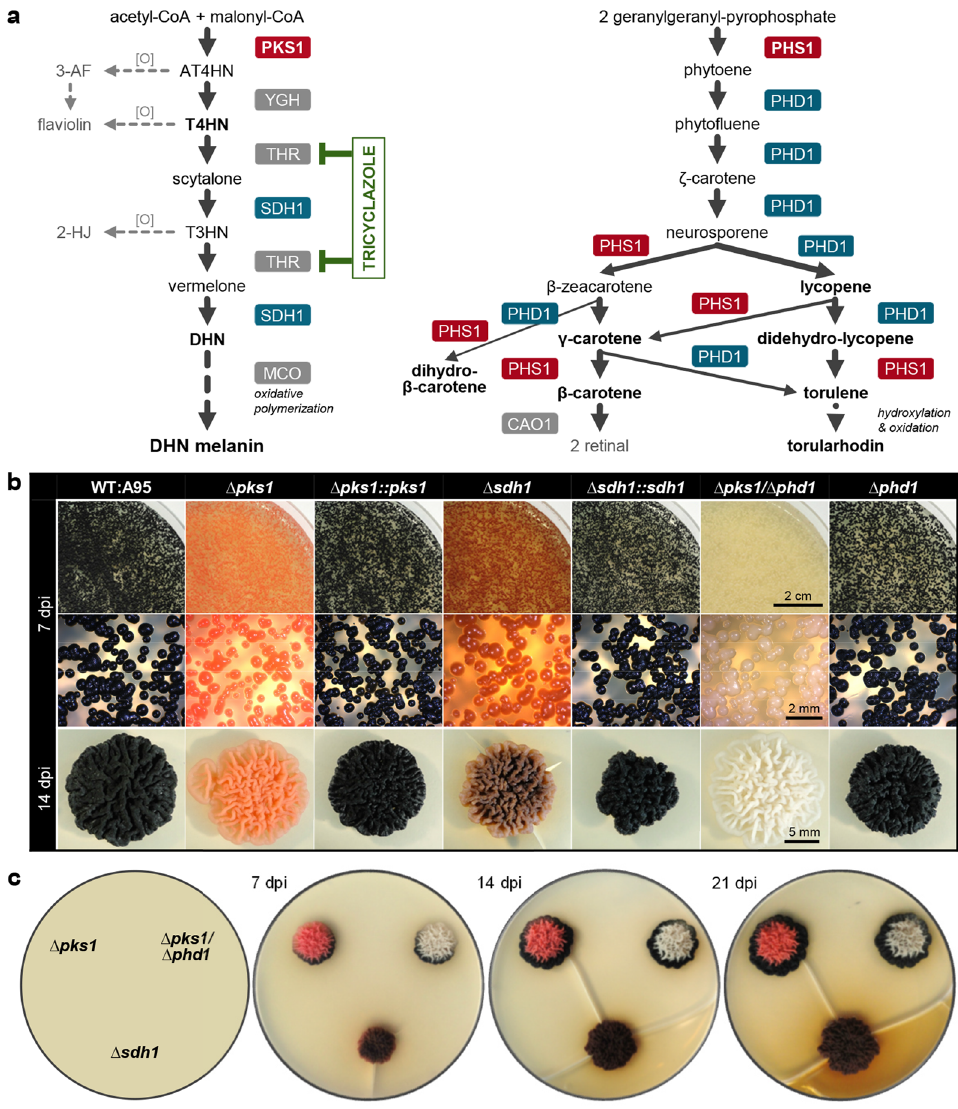
Figure 2. Traditional gene replacement approaches reveal the genetics of pigmentation. ( a ) Assumed pathways of DHN melanogenesis and carotenogenesis in K. petricola . DHN melanin: The polyketide synthase PKS1 forms the first intermediate which is deacetylated by a yellowish-green hydrolase (YGH). Further modifications of the intermediates are carried out by THN reductases (THRs) and the scytalone dehydratase SDH1. Polymerisation of DHN involves multicopper oxidase (MCO) activity. Tricyclazole specifically inhibits THR activity. Shunt products resulting from oxidation [O] are shown in grey. Other abbreviations: DHN—1,8-dihydroxynaphthalene, AT4HN—2-acetyl-1,3,6,8-tetrahydroxynaphthalene, T4HN— 1,3,6,8-tetrahydroxynaphthalene, T3HN—1,3,8-trihydroxynaphthalene, 3AF—3-acetylflaviolin, 2-HJ—2-hydroxyjuglone. Carotenoids: The bifunctional phytoene synthase/lycopene cyclase PHS1 forms the colourless precursor phytoene by condensation of two geranylgeranyl pyrophosphate molecules and catalyses the cyclization of the acyclic ends of lycopene as β-rings. The phytoene desaturase PHD1 introduces conjugated double bonds shifting the absorption maxima of the compounds towards longer wavelengths. Compounds indicated in bold letters have been isolated from WT:A95 cultures. Cleavage of β-carotene by the carotenoid oxygenase CAO1 may lead to the chromophore retinal. Carotenogenic genes are physically linked (Fig. S3). ( b ) Deletion mutants exhibit defects in DHN melanogenesis and/or carotenogenesis. Melanogenic genes ( pks1 , sdh1 ) and a carotenogenic gene ( phd1 ) were replaced by hygR or natR cassettes in WT:A95 (Figs. S2 and S3). The double mutant was generated by deleting phd1 in the ∆ pks1 background. Protoplasts were transformed with PCR-amplified replacement fragments containing homologous sequences of at least 2 kb. Pigmentation of ∆ pks1 and ∆ sdh1 mutants was rescued by reintroduction of the corresponding genes (∆ pks1 :: pks1 , ∆ sdh1 :: sdh1 ) (Tables S1 and S2). Malt extract agar (MEA) was inoculated with cell suspensions (1 × 10 5 cells/Petri dish) (upper/middle row) and (5 × 10 3 cells/10-µl droplet) (lower row) and incubated at 25 °C in darkness. dpi—days post inoculation. ( c ) Cross-feeding restores melanogenesis in ∆ pks1 mutants. MEA was inoculated with 10 µl droplets containing 5 × 10 3 cells and incubated at 25 °C. The ∆ sdh1 mutant secreted brownish metabolites that were converted to DHN melanin in ∆ pks1